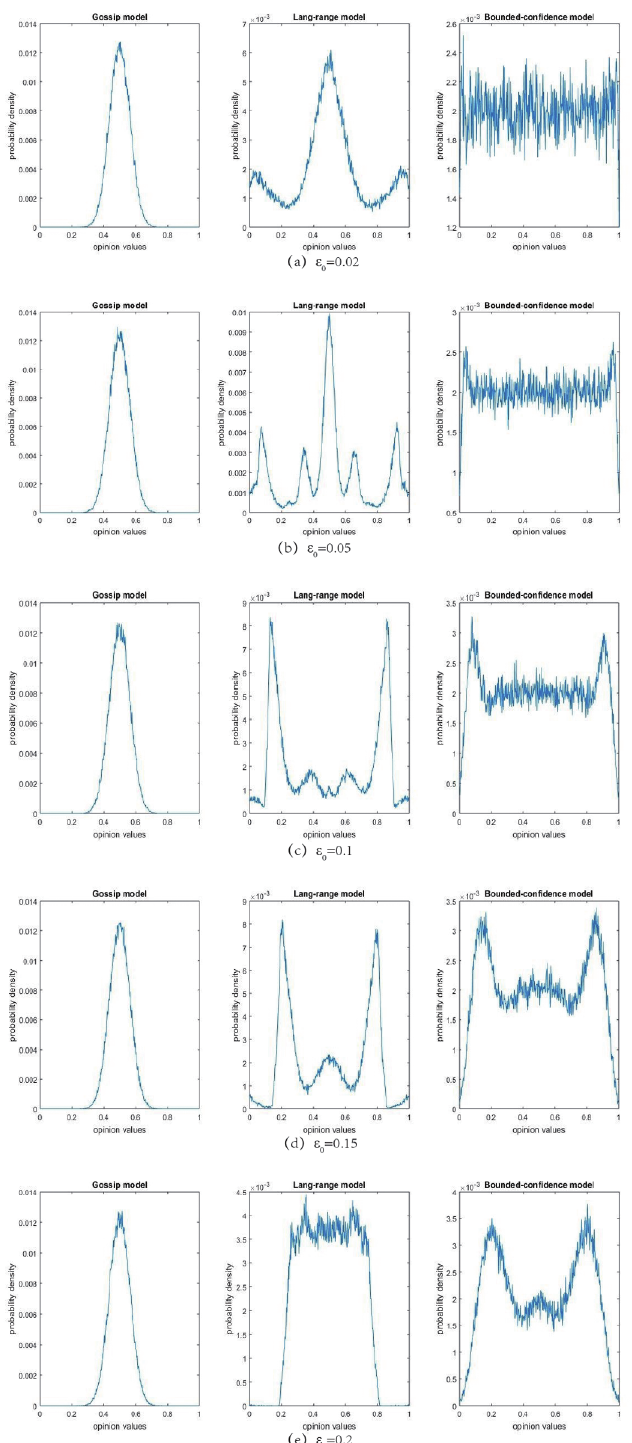
Fig 2. The change of one single agent opinion’s limit distribution.